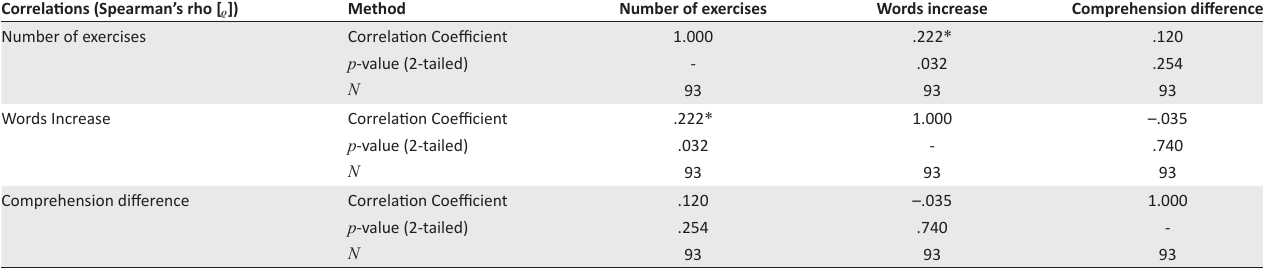
TABLE 2: Spearman’s rho calculations of correlation between variables. Correlations (Spearman’s rho [ ᵨ